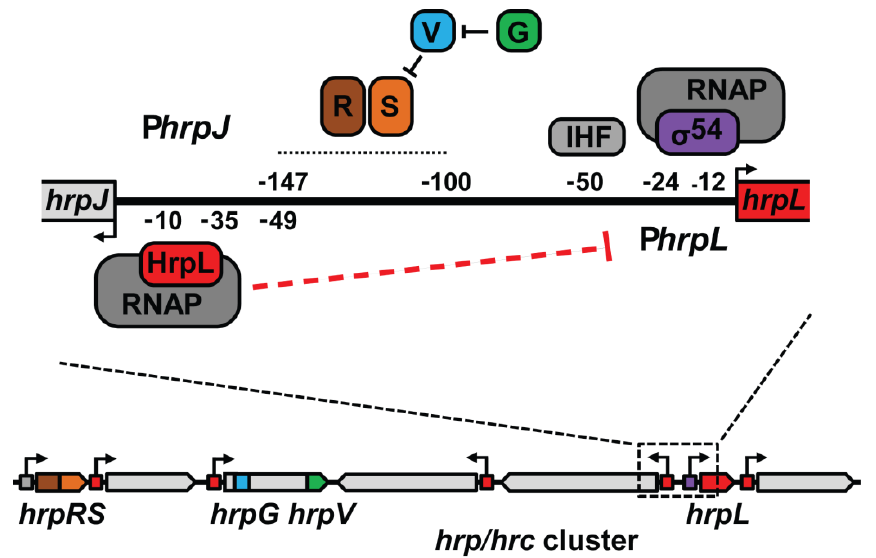
FIGURE 1: The regulation of hrpL tran- scription in P. syringae . Organisation of the bi-directional promoter region be- tween hrpL and hrpJ , including known binding sites for σ 54 , IHF, and